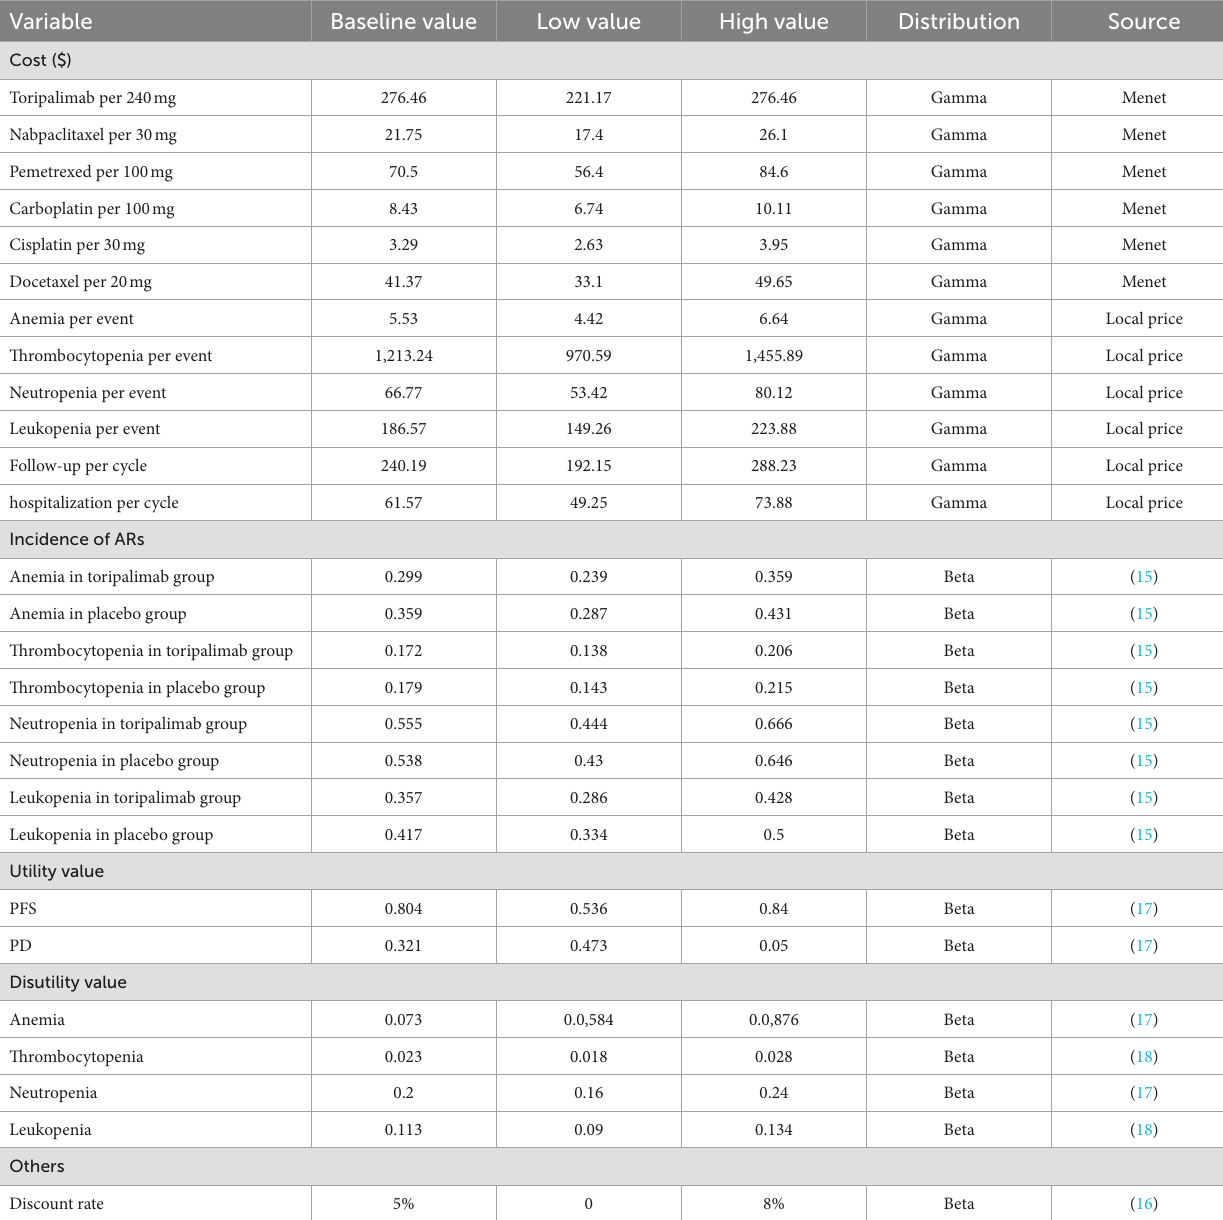
TABLE 1 Cost and utility